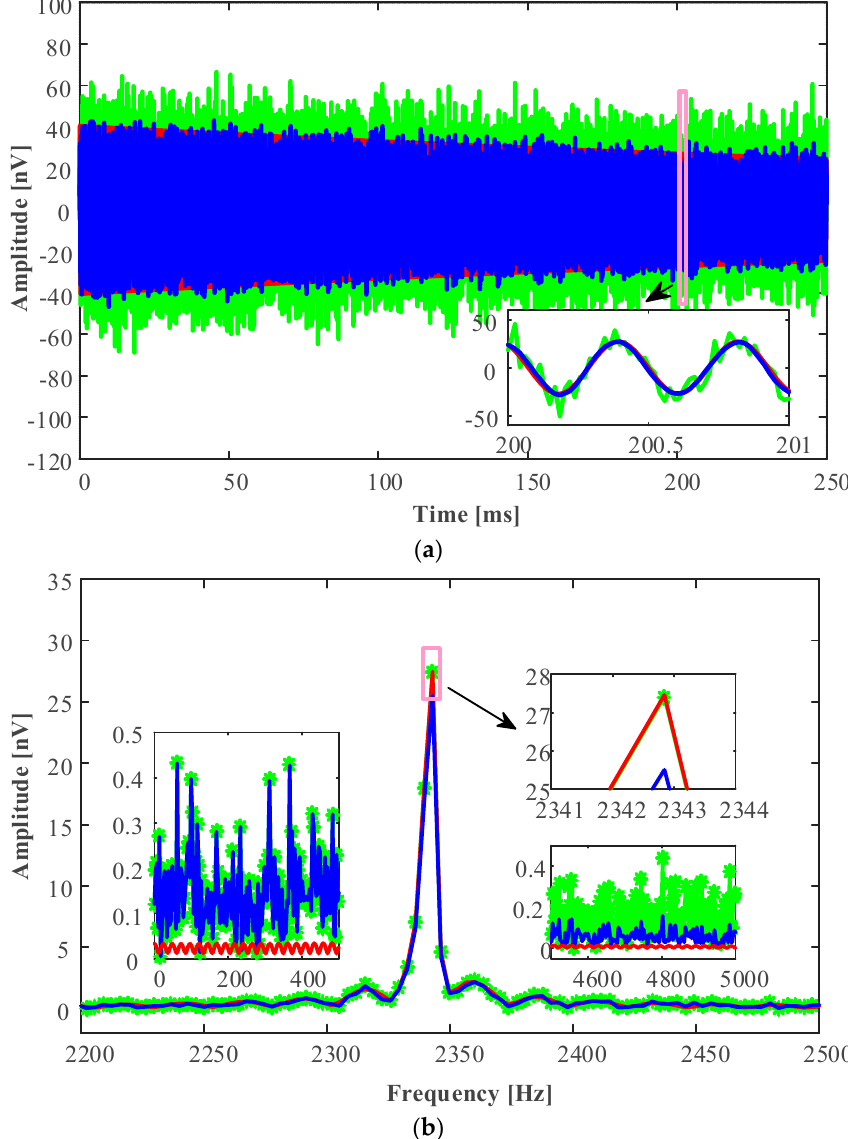
Figure 13. Waveform comparison of the data processed by the local quadratic estimator (window size 19 and smoothing factor h = 5/ f prop ). ( a ) Comparison in time domain. ( b ) Comparison in frequency domain. The green lines display the data by the rectangular sparse reconstruction method. The red lines display the ideal signal. The blue lines display the data by the rectangular sparse reconstruction method and the local quadratic kernel regression estimation. In other words, the blue lines display the ISSR-KRE